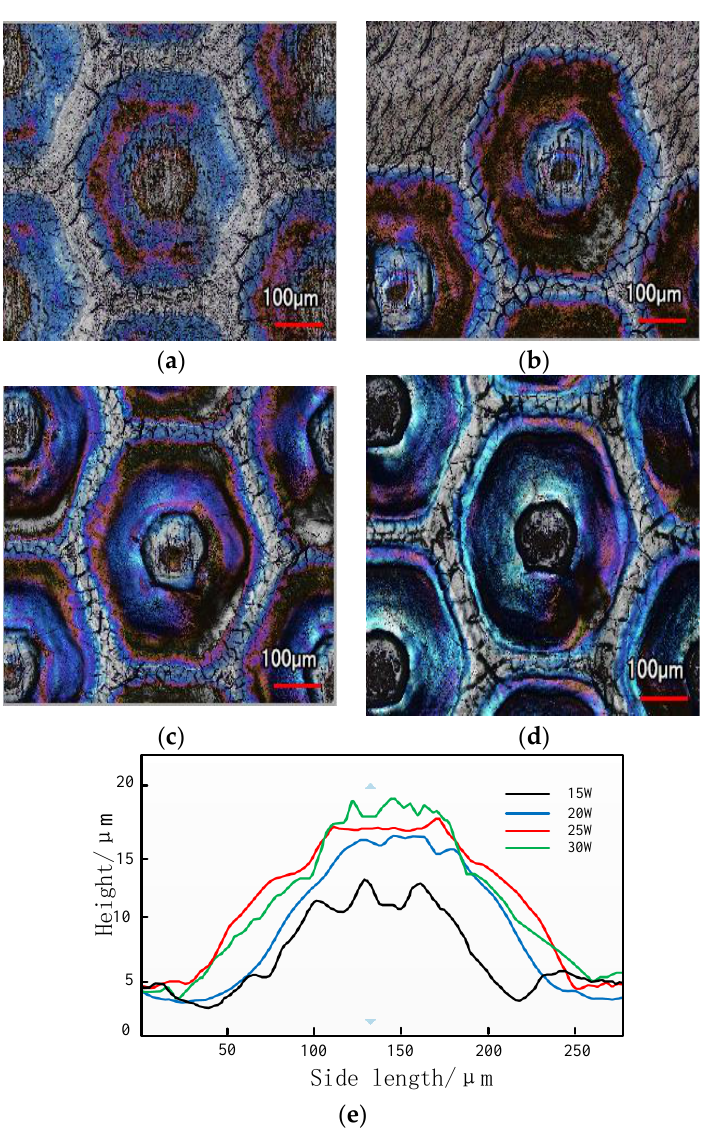
Figure 10. The relationship between machining power and the appearance of the surface. ( a ) P = 15 W, ( b ) P = 20 W, ( c ) P = 25 W, ( d ) P = 30 W, ( e ) Contour graph for different power.